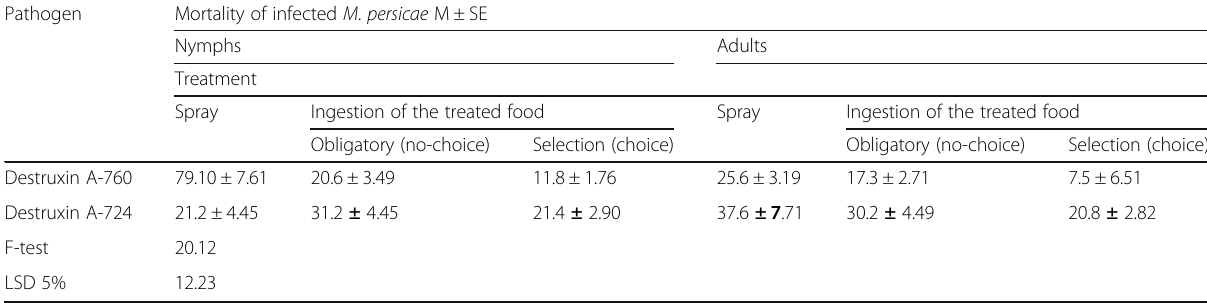
Table 3 Determination of the effect of (Destruxin A- 760 and Destruxin A- 724 ) on developmental stages of C . undecimpunctata after feeding M . persicae nymphs and adults Pathogen